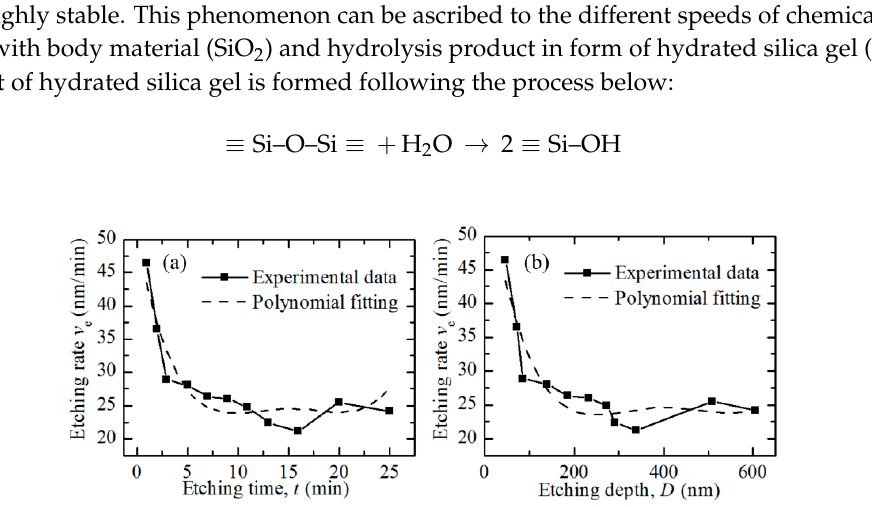
Figure 10. The evolution of etching rate with respect to the etching time ( a ) and etching depth ( b ).